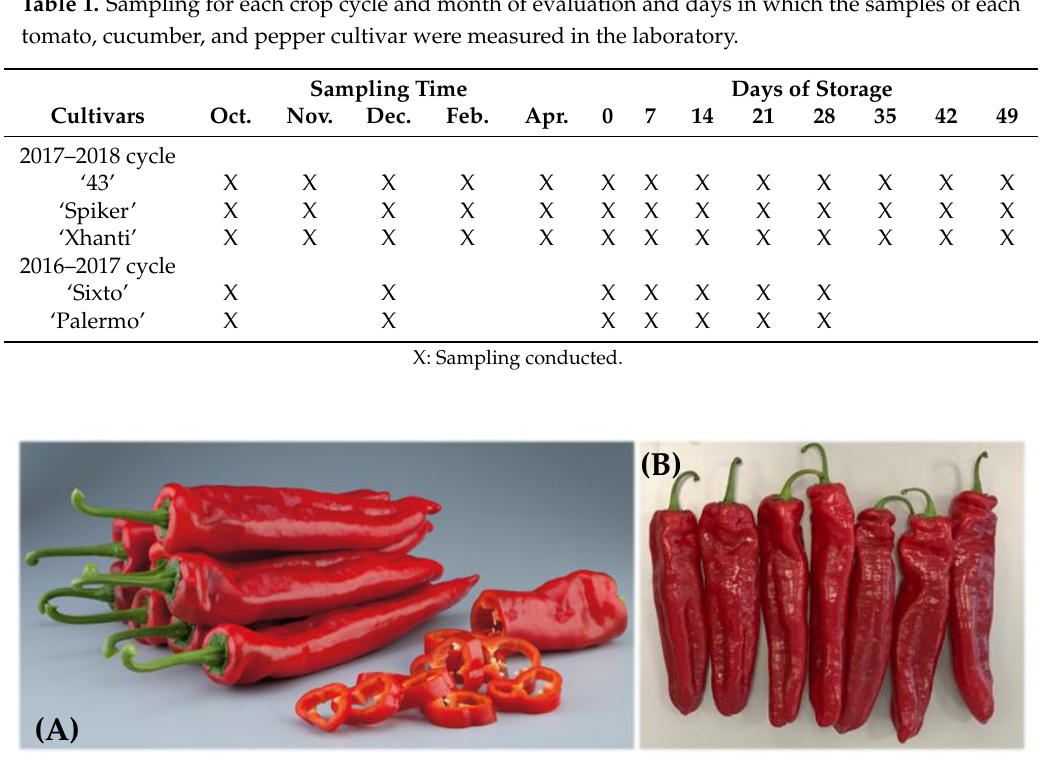
Figure 3. “Italian sweet” red pepper fruits evaluated. ‘Sixto’ cultivar ( A ) and ‘Palermo’ cultivar ( B ). Figure 3 . “ Italian sweet ” red pepper fruits evaluated. ‘ Sixto ’ cultivar (A) and ‘ Palermo ’ cultivar (B). The fruit samples evaluated came from plants grown in greenhouses located in south-eastern Spain (Almer í a, Spain). All the crops were transplanted in August, and the agronomic practices Table 1 . Sampling for each crop cycle and month of evaluation and days in which the samples of each (irrigation, fertilisation, pruning, etc.) were the usual ones for pepper cultivation in the producing area. tomato, cucumber, and pepper cultivar were measured in the laboratory. The producers were professionals dedicated to the production and export of pepper, so the state of maturity of the samples was optimal for marketability (Figures 2 and